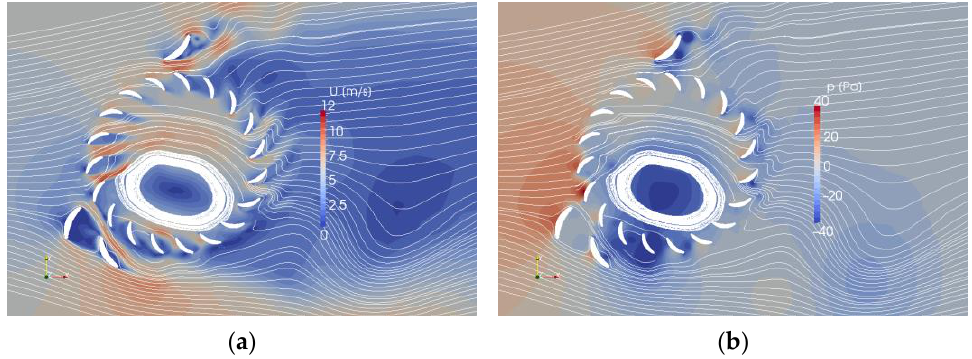
Figure 15. Velocity and pressure distribution and streamlines of the cross-flow wind turbine with TFD of inclination angle θ = 0 deg., ( a ) velocity distribution, U ; ( b ) pressure distribution, p .